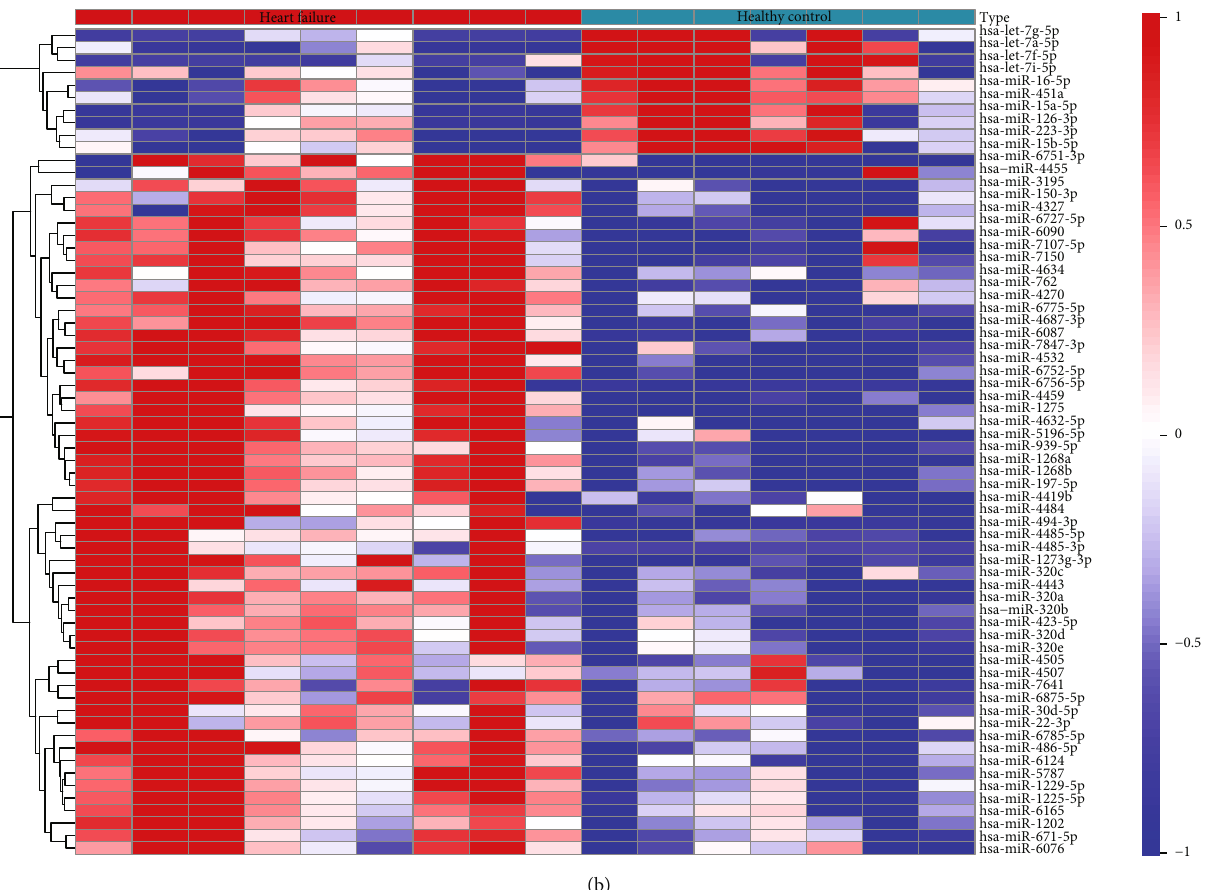
Figure 1: Di ff erentially expressed miRNA analysis on the GSE104150 dataset: (a) volcano plot of miRNA di ff erential analysis; (b) heat map of di ff erential miRNA